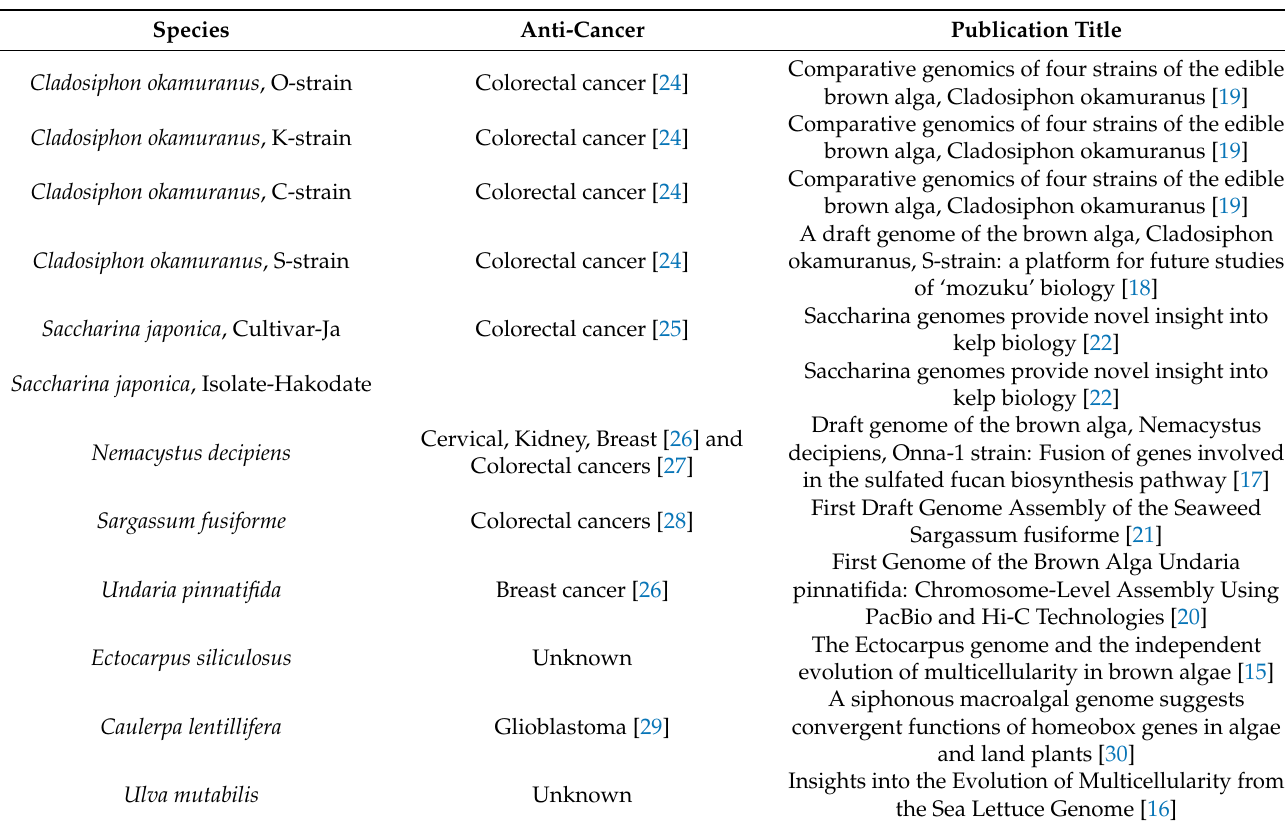
Table 1. Summary of 12 seaweeds with publicly available